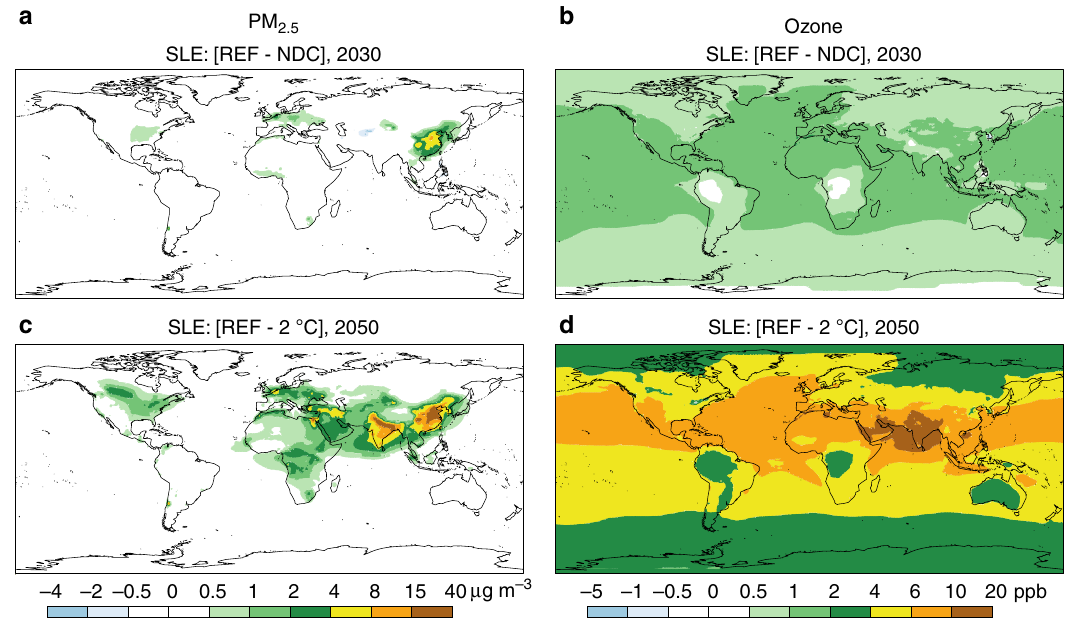
Fig. 3 Reduction of PM 2.5 concentration ( μ g m − 3 ) and ozone mixing ratio (ppb) due to climate change mitigation policies under the Stringent Legislation case of air quality. NDC scenario compared with the Reference in 2030 (REF — NDC) for a PM 2.5 and b ozone. 2 °C scenario compared with the Reference in 2050 (REF — 2 °C) for c PM 2.5 and d ozone. Positive values indicate improved air